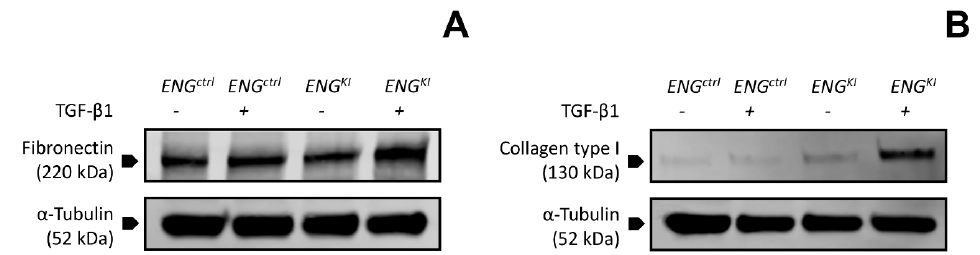
Figure 5. ENG K I fibroblasts have an increased TGF- β‒ induced production of fibronectin and col- lagen type I. ENG ctrl and ENG KI fibroblasts were incubated with (+) and without (-) 5 ng/mL TGF- β 1 for 24 h, after which a Western blot for collagen type I ( A ) and fibronectin ( B ) was executed. Relative upregulation of collagen type I ( C ) and fibronectin ( D ) protein levels upon TGF- β stimulation are displayed relative to their own unstimulated control. Protein levels were corrected for the loading control α -Tubulin. Summary data are presented as means ± SD from three independent experi- ments. * p < 0.05 (Student’s t -test after log transformation). 3. Discussion Here, we show that endoglin is upregulated in the interstitium of patients with CKD compared to ET control kidneys. Endoglin was present in the areas where Sirius Red was most prominent. Furthermore, the interstitial area positive for endoglin correlated with the eGFR; this finding was independent of the patient’s diagnosis. These results indicate that endoglin is upregulated in the final common pathway of CKD rather than being of relevance in one specific kidney disease. Importantly, we show that overexpression of en- doglin increases the profibrotic response in TGF- β 1-stimulated human kidney fibroblasts. This effect was shown at the mRNA level for ACTA2, a precursor of the differentiation marker α -SMA [32], for CCN2 and SERPINE1 , both pro-fibrotic downstream targets of the TGF- β 1 signaling pathway [33,34] and for COL1A1 and FN1 , which translated into an in- crease in protein expression of the ECM molecules collagen type I and fibronectin [6]. To- gether, these results indicate that endoglin is not only overexpressed in patients with pro- gressive chronic kidney disease but also suggest that overexpression of endoglin in the interstitium contributes to interstitial fibrosis. Our finding that endoglin is upregulated in various chronic kidney diseases is in line with current literature. For instance, it has been described that endoglin is upregulated in cardiac fibroblasts in the left ventricle of patients with heart failure [23]. Upregulation of